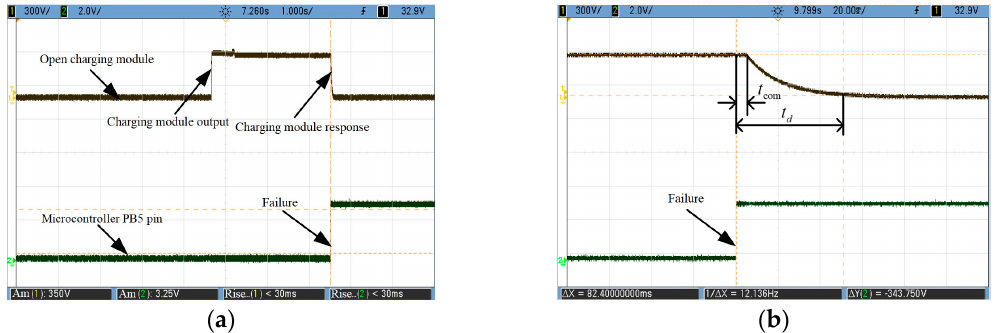
Figure 9. Simulated fault and voltage waveforms: ( a ) fault simulation and ( b ) zoom-out view.